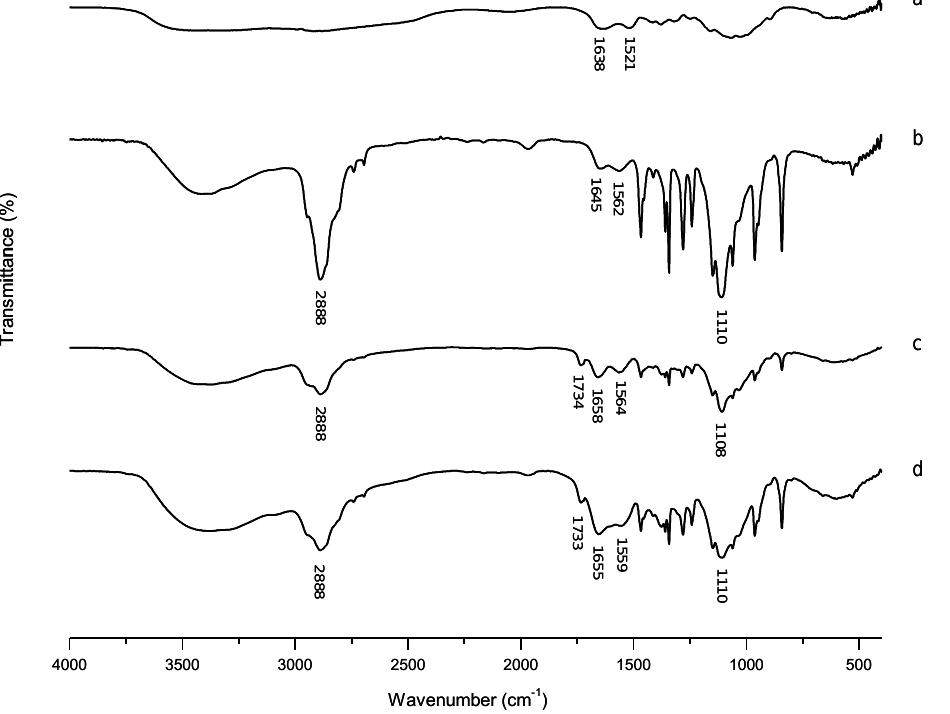
Figure 2. FT-IRspectraof( a )chitosan(CS),( b )mPEG-CS,( c )mPEG-CS-CHO,and( d Figure 2. FT-IR spectra of (a) chitosan (CS), (b) mPEG-CS, (c) mPEG-CS-CHO, and (d) mPEG-CS(SH)-CHO.